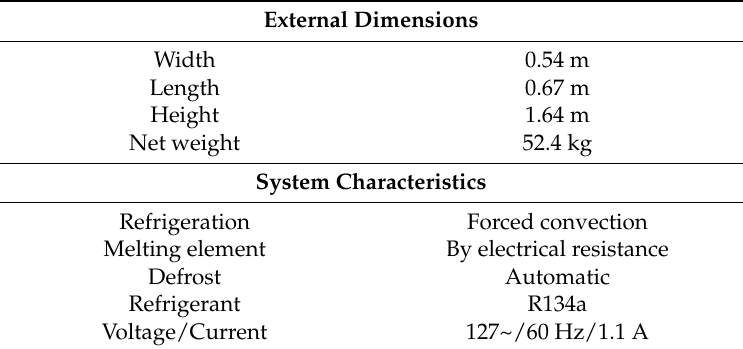
Table 1. General features of the experimental